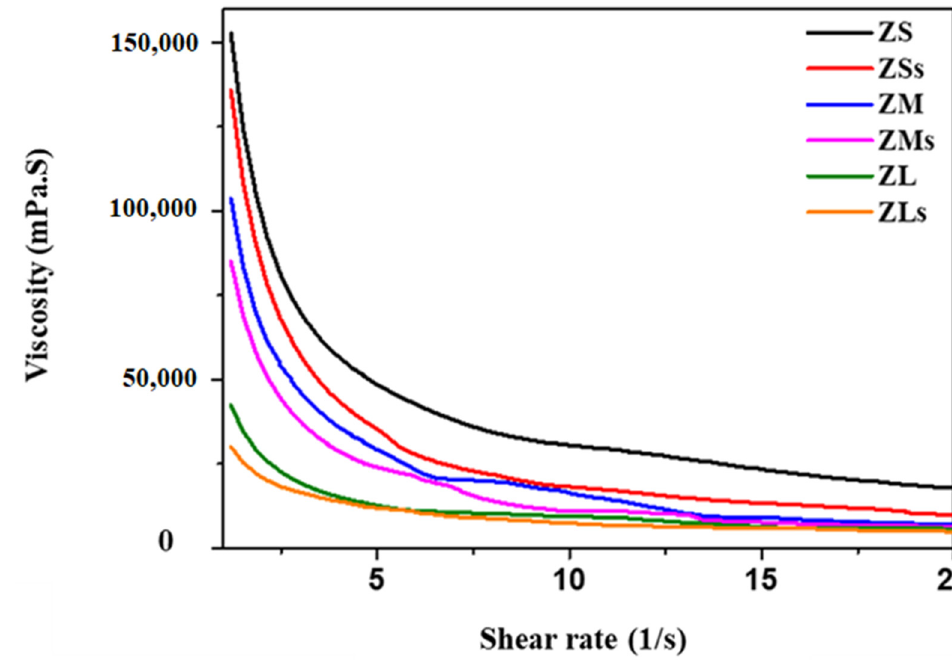
Figure 9. The viscosity of various zirconia suspensions before and after silane coating.